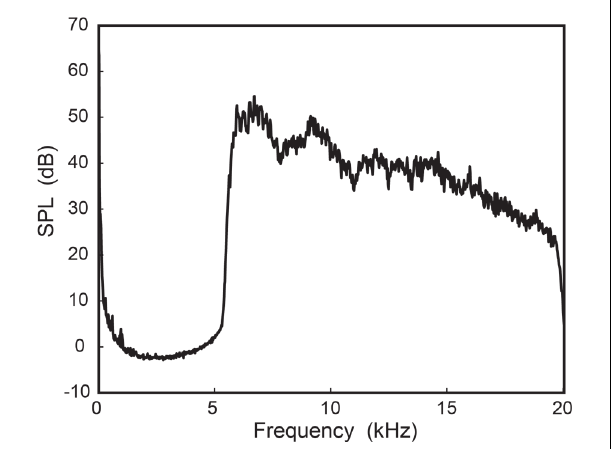
FIGURE 1 | Long-term average spectrum (LTAS) of high-frequency energy (HFE). The HFE was extracted from the first 5 s of one